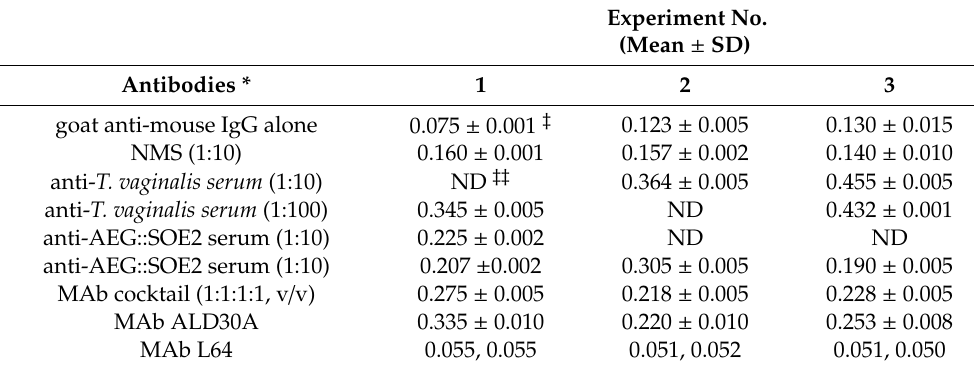
Table 4. Whole cell ELISA for detection of anti- T. vaginalis mouse serum IgG antibody and monoclonal antibody (MAb).